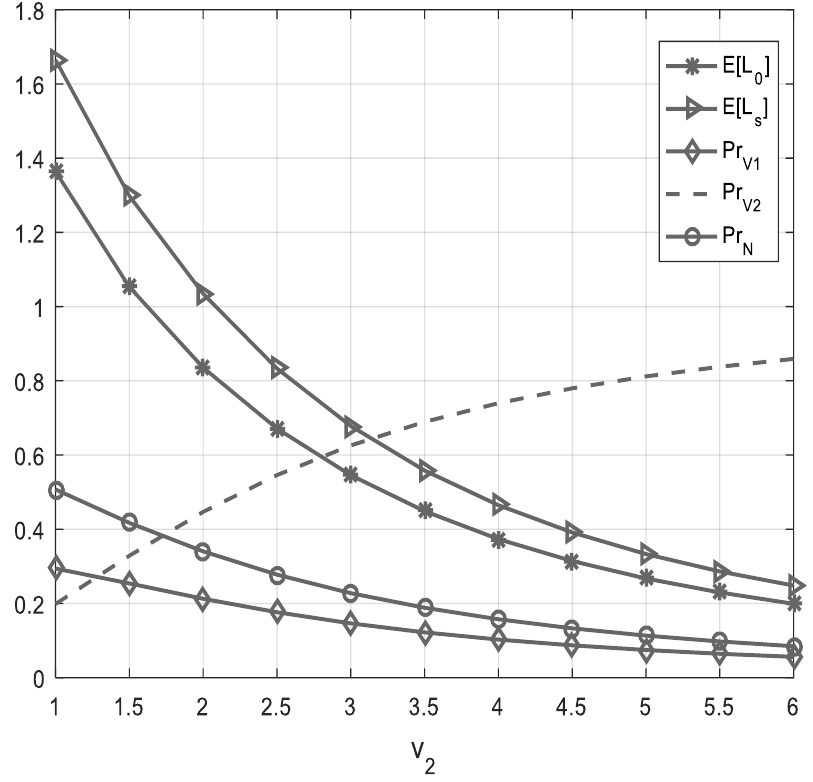
Figure 5. Effect of variation in rate of type II vacation ( 𝑣 performance